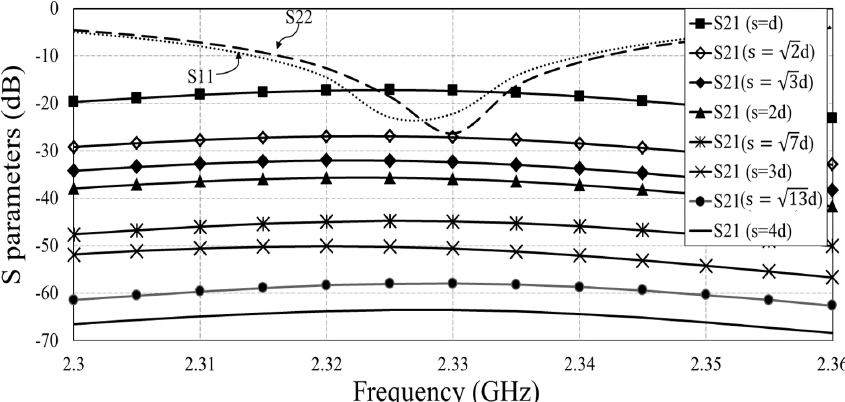
Figure 11. Simulated return loss ( S 11, S 22) and mutual couplings ( S 21) versus frequency with different separation, S